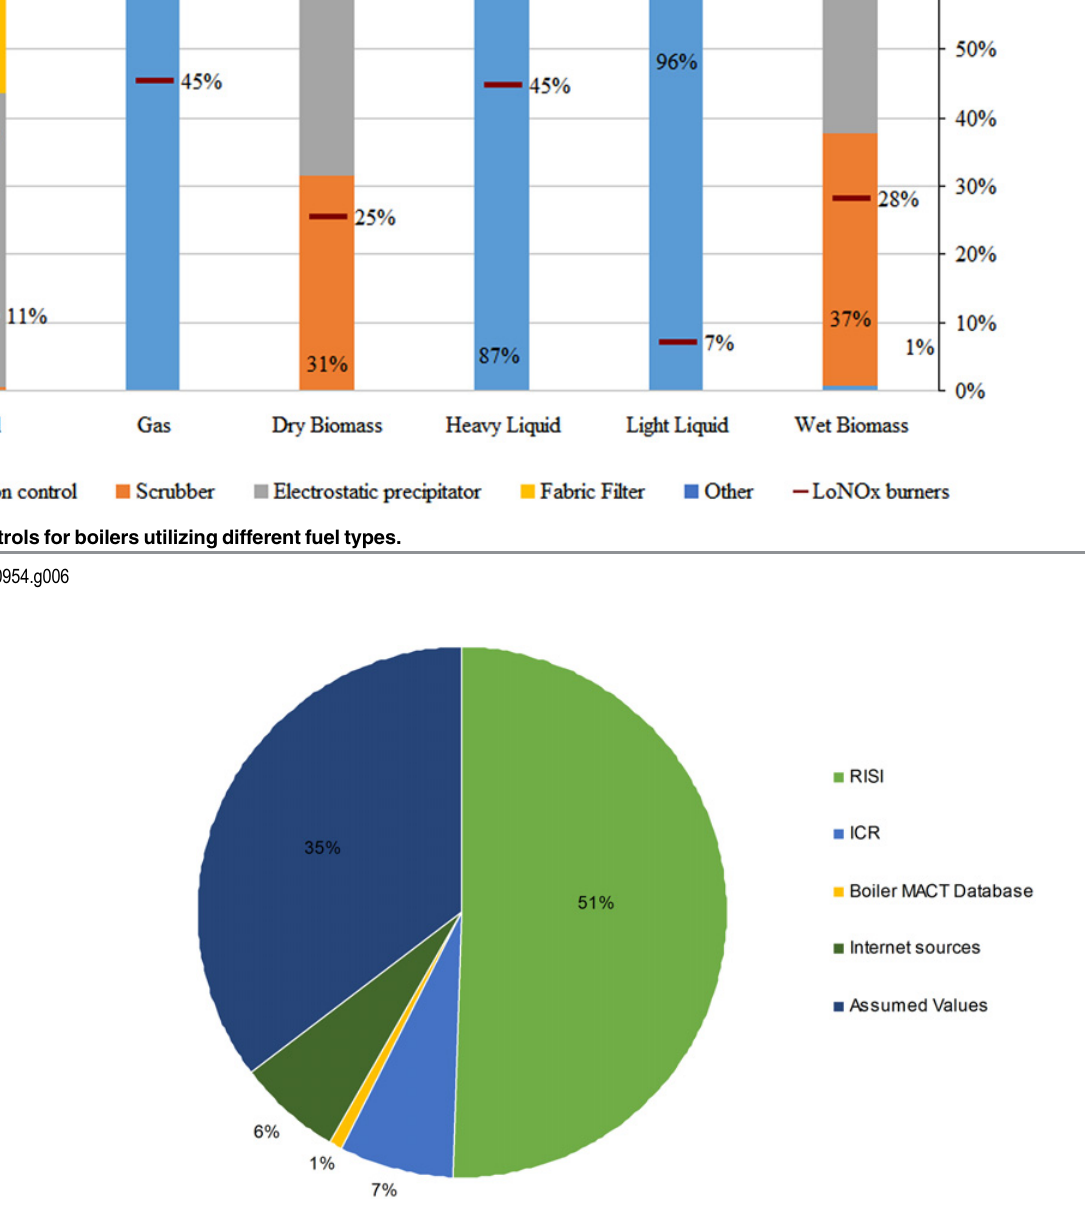
Fig 7. Percentages of available data from each source utilized in developing the